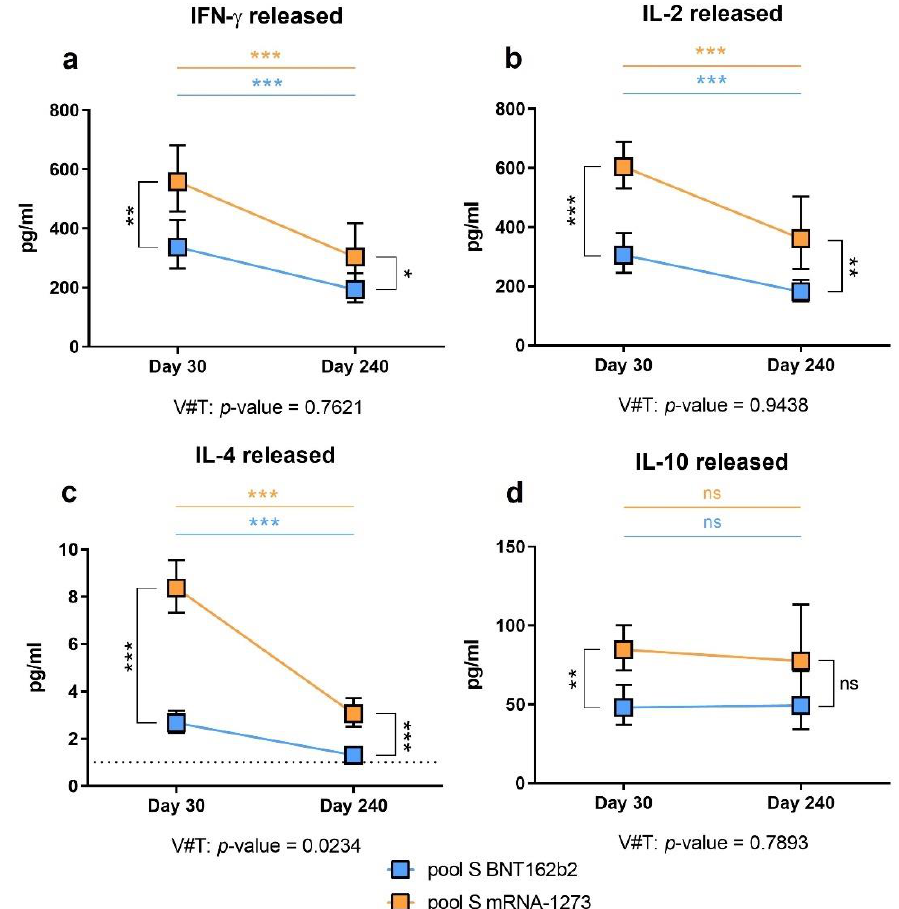
Figure 3. Specific cellular immunity after stimulation with the S pool. The estimated means and confidence intervals were calculated by multiple linear regression model, adjusted by age and gender and with Bonferroni’s correction. Squares represent the mean and confidence intervals for IFN- γ ( a ), IL-2 ( b ), IL-4 ( c ), and IL-10 ( d ), at day 30 and 240, for BNT162b2 (in blue) and mRNA-1273 (in orange). Lower limit of detection (LLOD) is indicated by the dotted line for IL-4 (1 pg/mL). The evolution for each cytokine was assessed by the mixed-effects model. V#T indicates the interaction between the type of vaccine and the time evolution. Non-significant (ns = p -value > 0.05). * p -value < 0.05. ** p -value < 0.01. *** p -value <